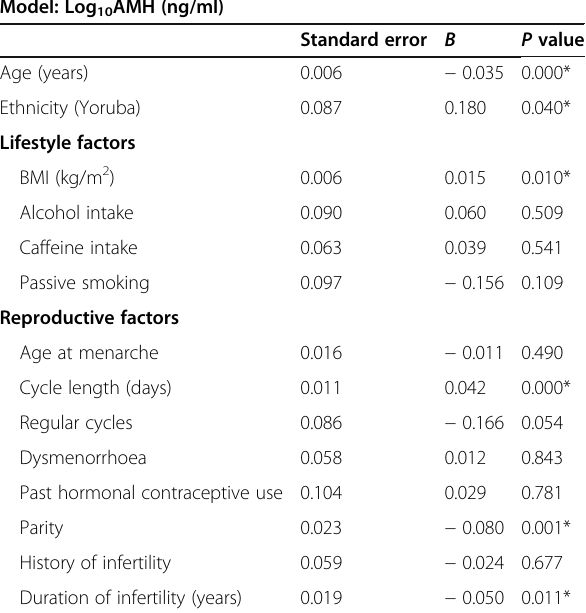
Table 2 Univariate linear regression analysis Model: Log 10 AMH (ng/ml)